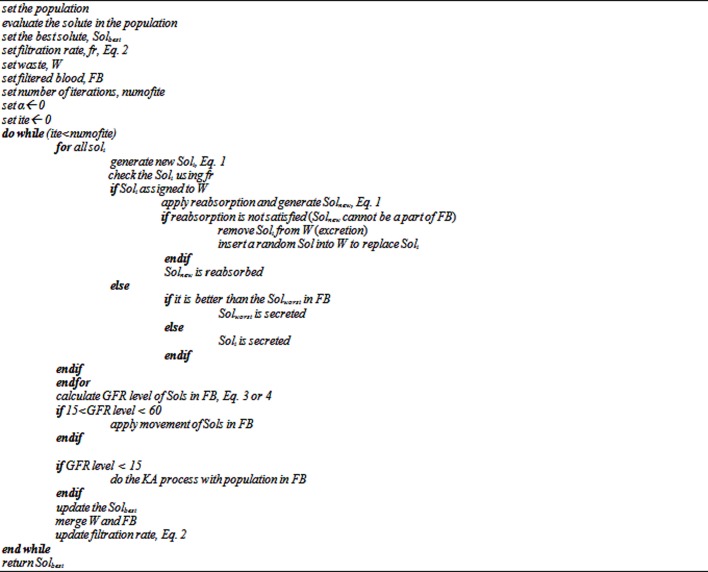
Pseudocode of KAT.